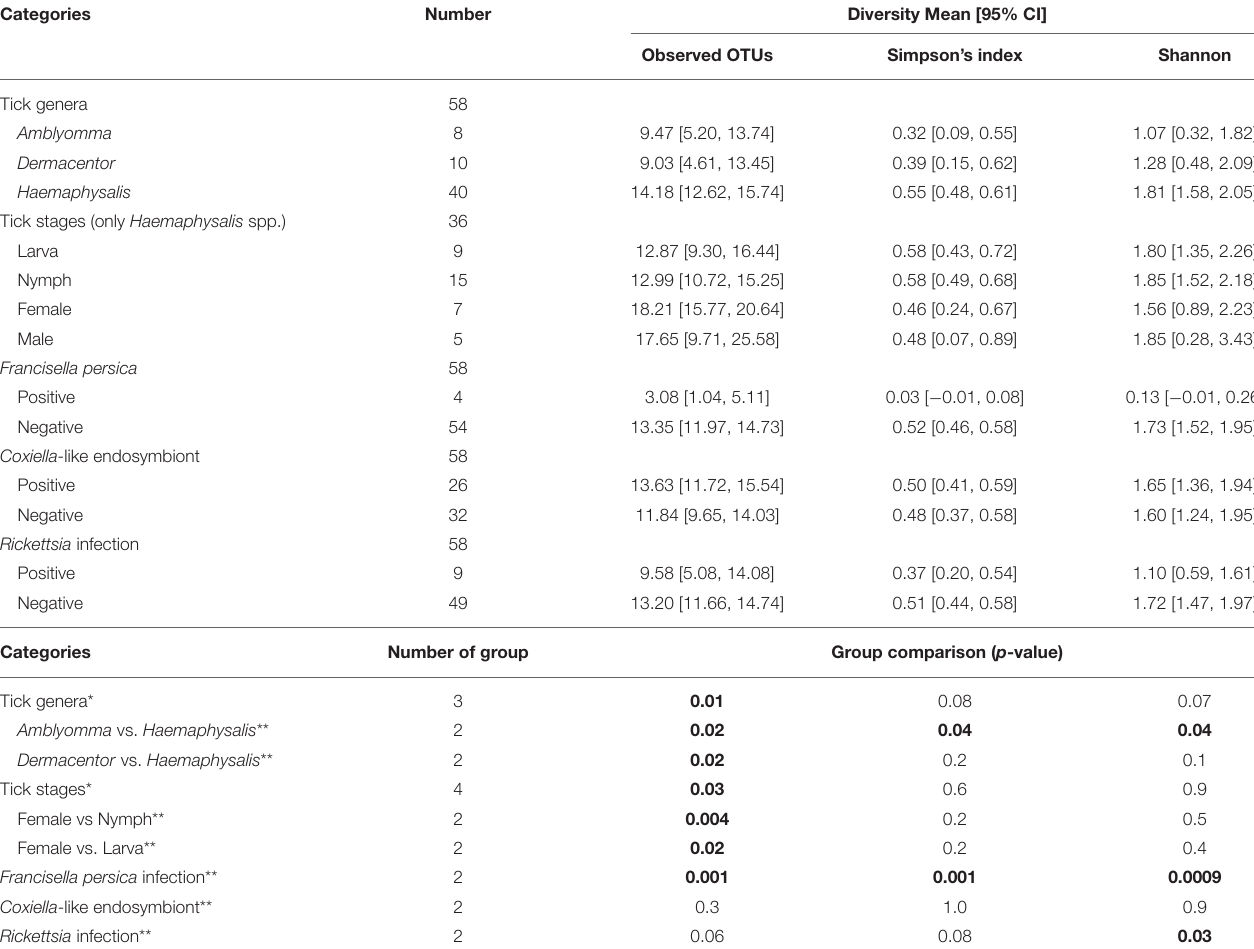
TABLE 5 | Alpha diversity estimates of bacterial communities based on